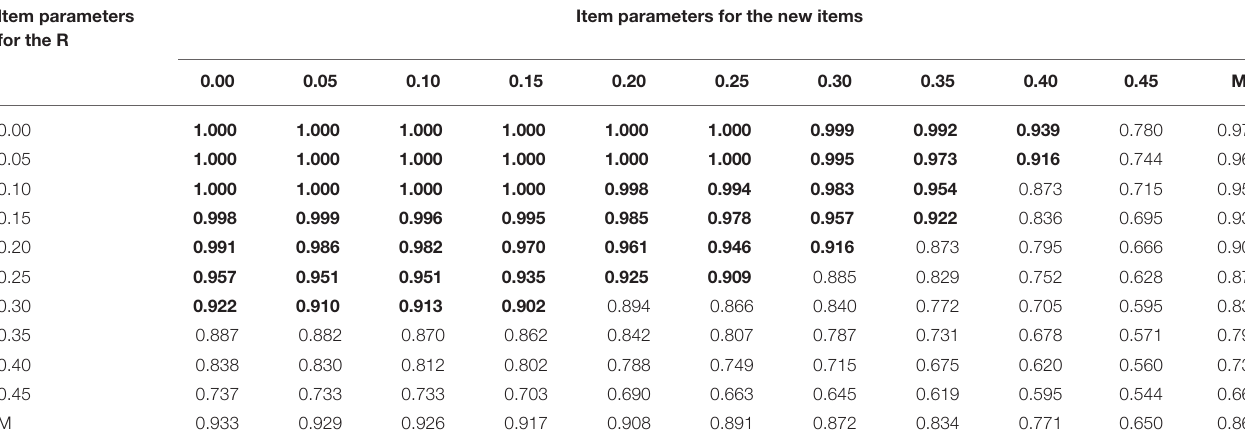
Item parameters for the new